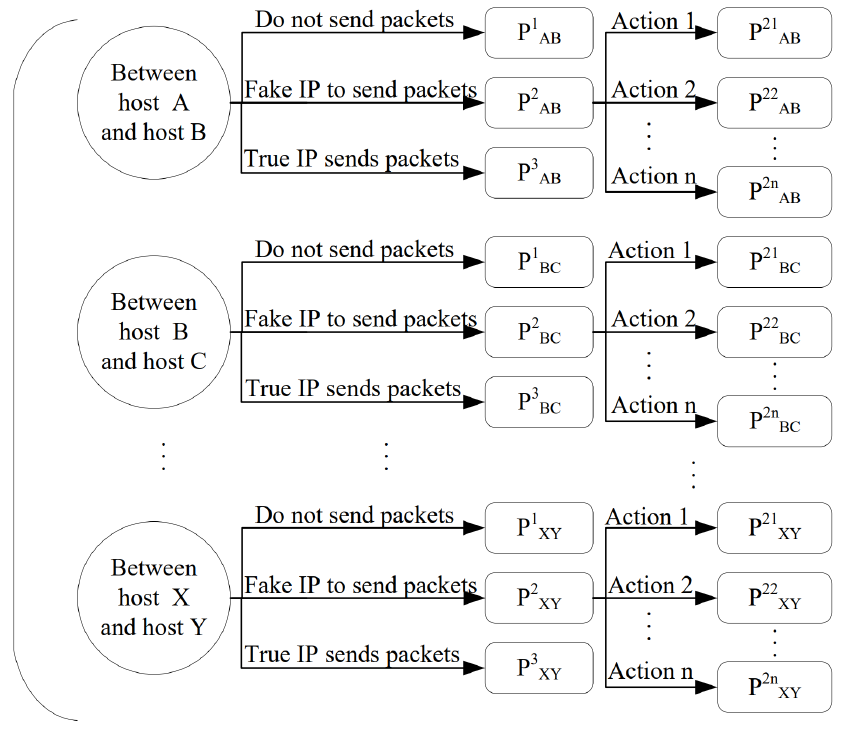
Figure 2. Probability diagram of contracting action